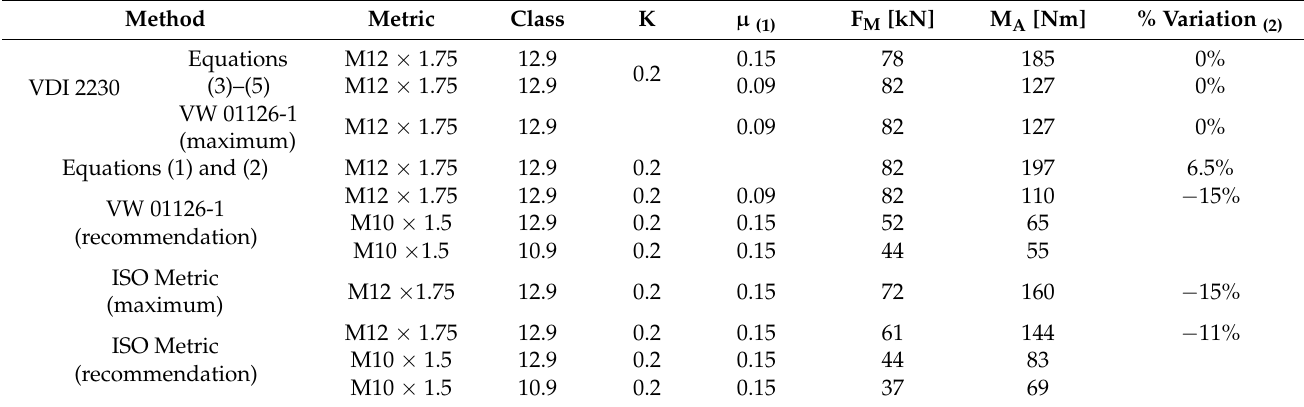
Table 1. Factor values F M y M A for M12 and M10 steel Allen